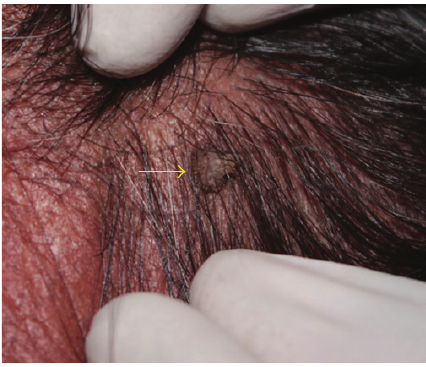
Figure 2: Wart seen on the scalp.